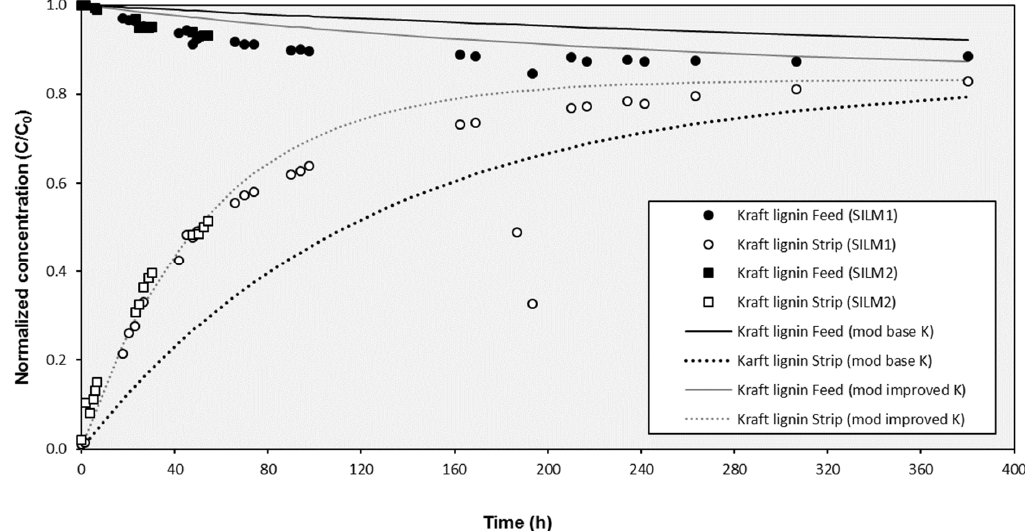
Figure 3. Evolution of the experimental concentration of Kraft lignin in the cell compartments during